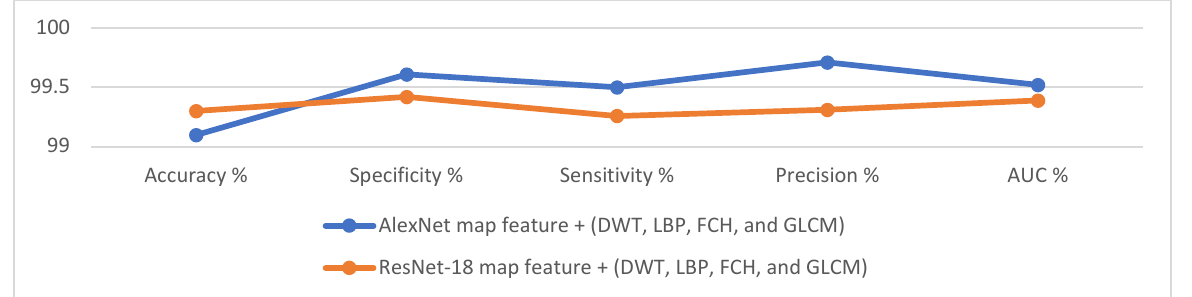
Figure 12. Confusion matrix for evaluating ANN performance based on hybrid features. ( a )